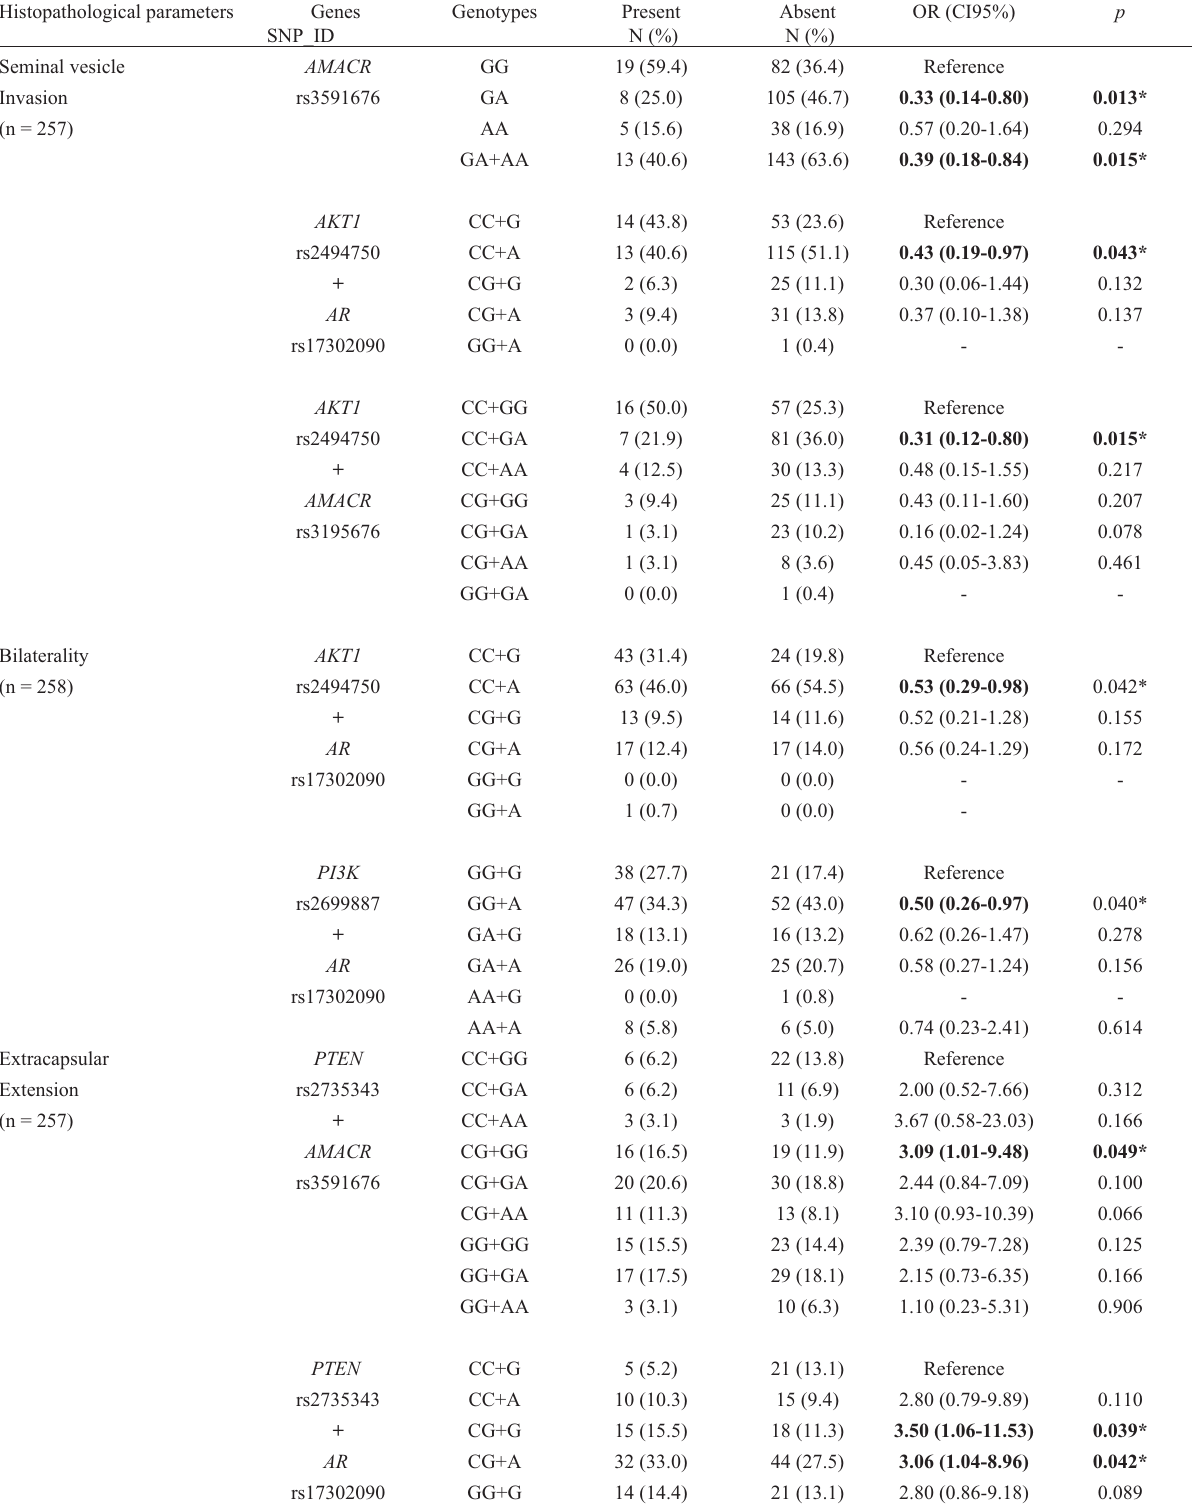
Table 5 - Univariate regression analysis between genotypes of PTEN , AKT , PI3K , AR , and AMACR genes with clinicopathological features in prostate cancer patients. Histopathological